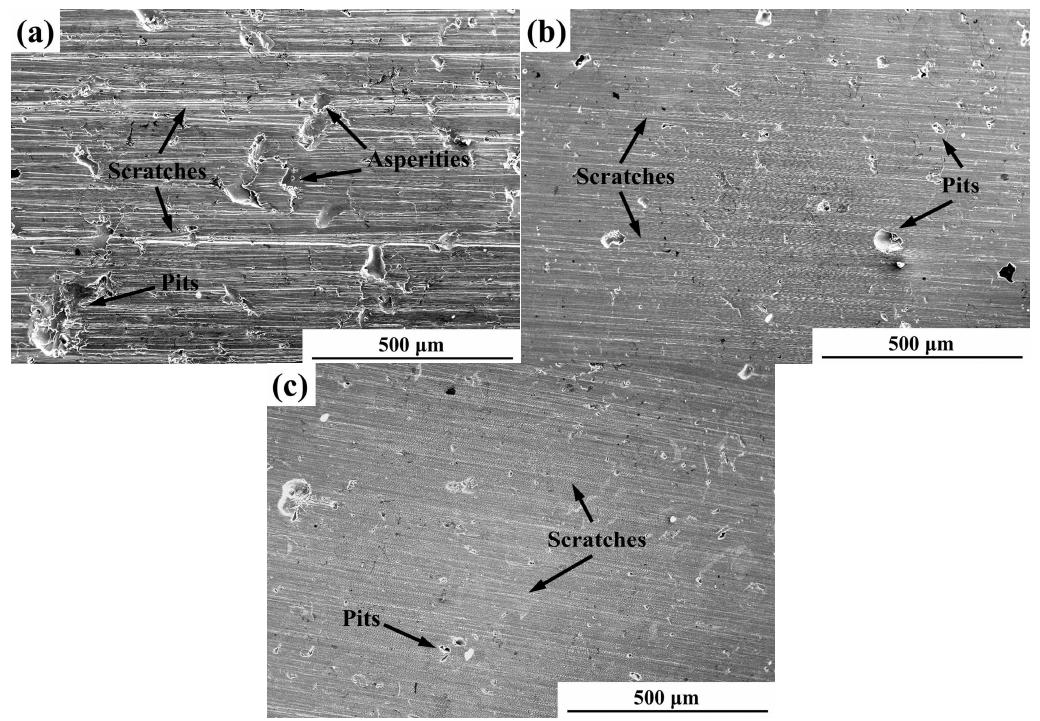
Figure 4. SEM images of the surface morphology of as-sprayed coatings under three surface conditions before the cavitation erosion test: ( a ) 80 grit grinding; ( b ) 600 grit grinding; and ( c ) 1000 grit grinding.